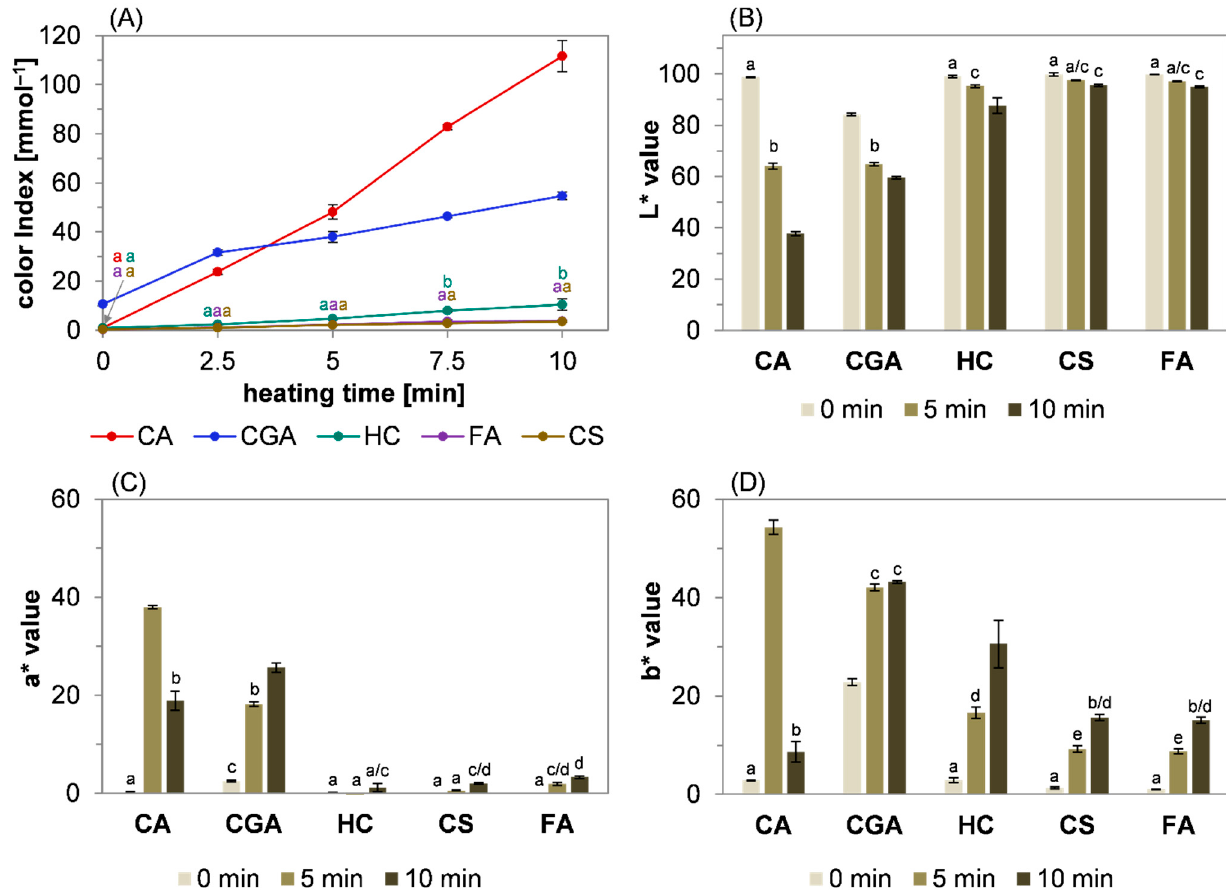
Figure 1. Time-dependent color formation of different hydroxycinnamic acid derivatives. Change in ( A ) the color index of caffeic acid (CA, red line), 5- O -caffeoylquinic acid (CGA, blue line), hydrocaffeic acid (HC, green line), para -coumaric acid (CS, brown line), and ferulic acid (FA, purple line) and ( B ) lightness (L*), ( C ) red/green intensity (a*), and ( D ) yellow/blue intensity (b*) over the course of roasting at 220 °C. Statistical analyses were performed by two-way ANOVA and T UKEY ’s test ( p < 0.05). Statistically equal values of the data points are designated by equal letters.